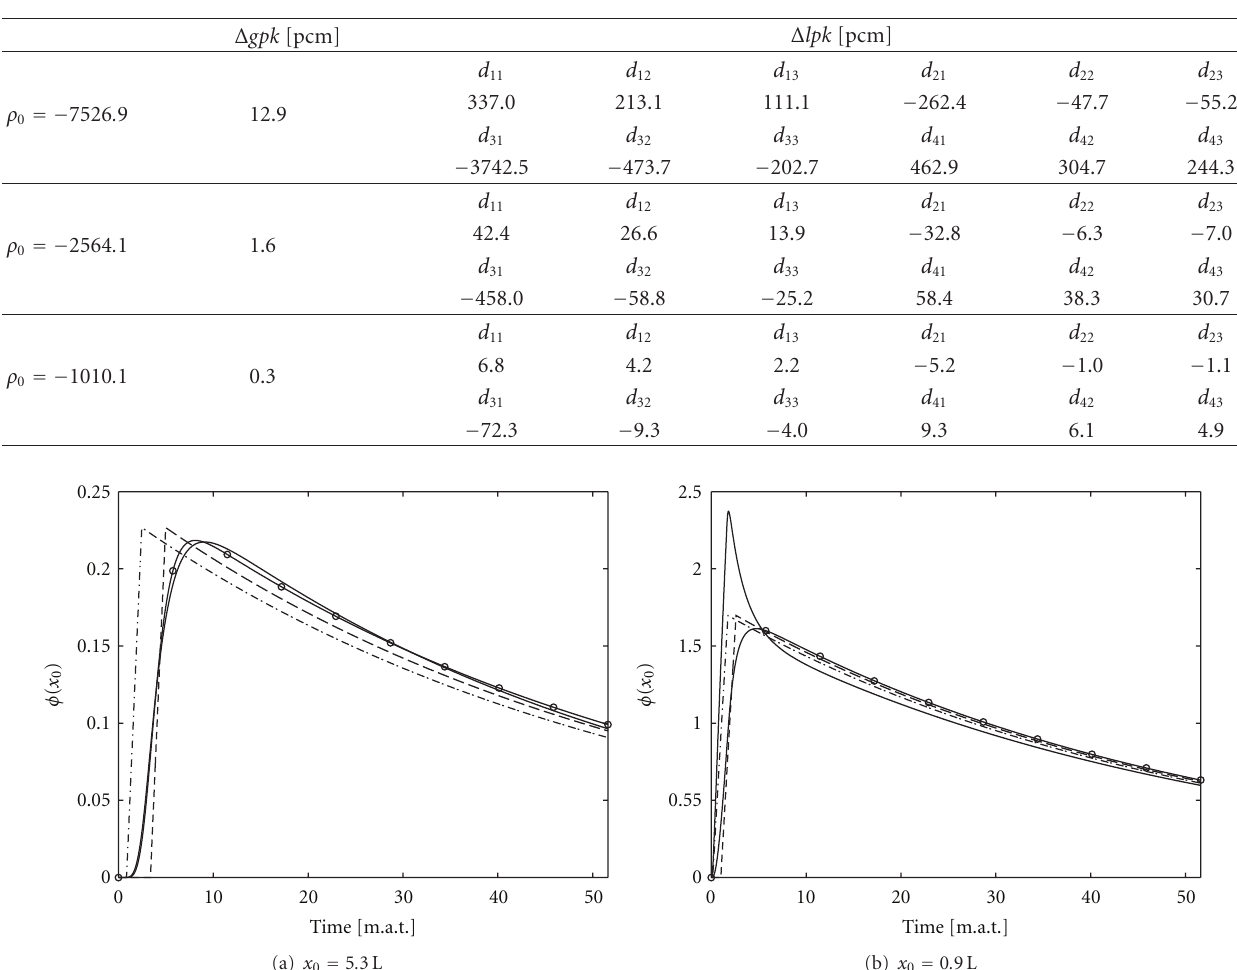
Table 5: Error in pcm on the subcriticality level as obtained by the di ff erent point kinetic models adopted in the one-dimensional domain sketched in Figure 10. The direct shape is assumed to be the subcritical source-driven distribution.